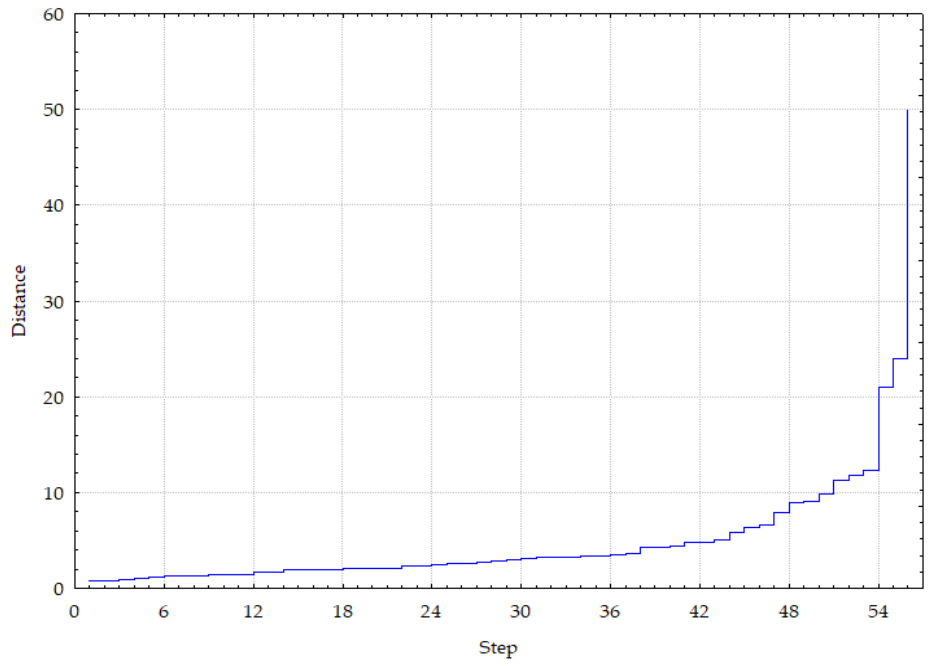
Figure 2. A graph of amalgamation schedule. Source: own study.